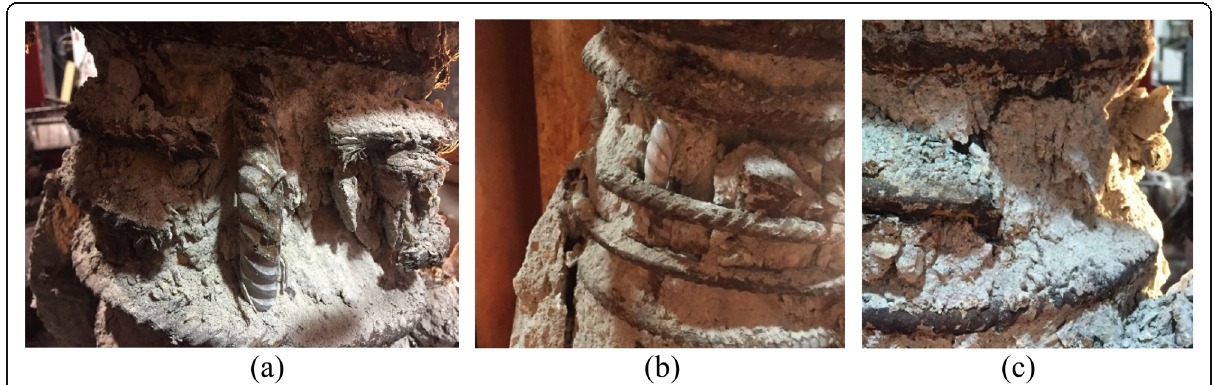
Fig. 12 Failure modes after axial compression tests: a multiple spiral fractures in NN-R-1; b spiral fracture and buckled vertical bars in CN-R-2; c fractured spiral in